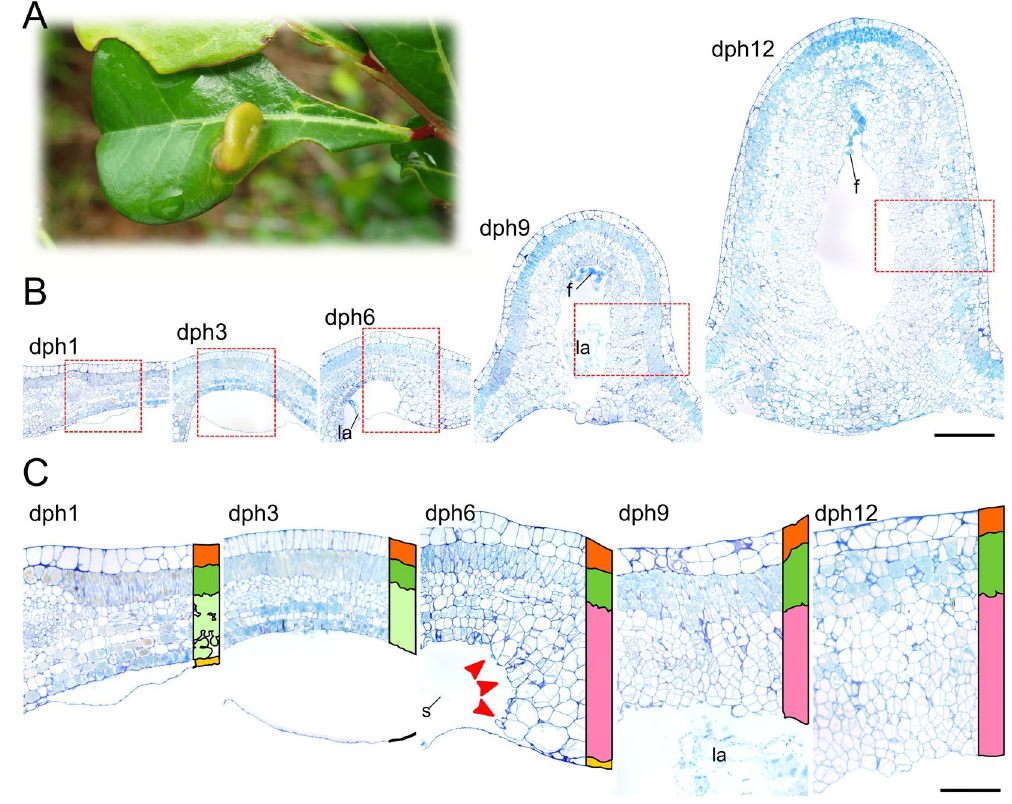
Figure 1. Gall initiated on Glochidion obovatum leaves attacked by Caloptilia cecidophora ( A ). Time series of histological sections of C . cecidophora gall initiation. ( B ) Cross sections of G . obovatum leaves attacked by C . cecidophora were made at 1 day post-hatching (dph1), at dph3, at dph6, at dph9, and at dph12. Red rectangles correspond to the zone detailed in ( C ). Legend, orange: upper epidermis, green: palisade parenchyma, light green: spongy parenchyma, yellow: lower epidermis, pink: altered parenchyma showing hypertrophied cells and an activation of cell division, s: silk, la: larvae, f: frass. Red arrows point cell division and hypertrophia orientated in direction to insect chamber. Scale: 500 µ m for ( B ), 100 µ m for ( C ). Staining: Toluidine Blue